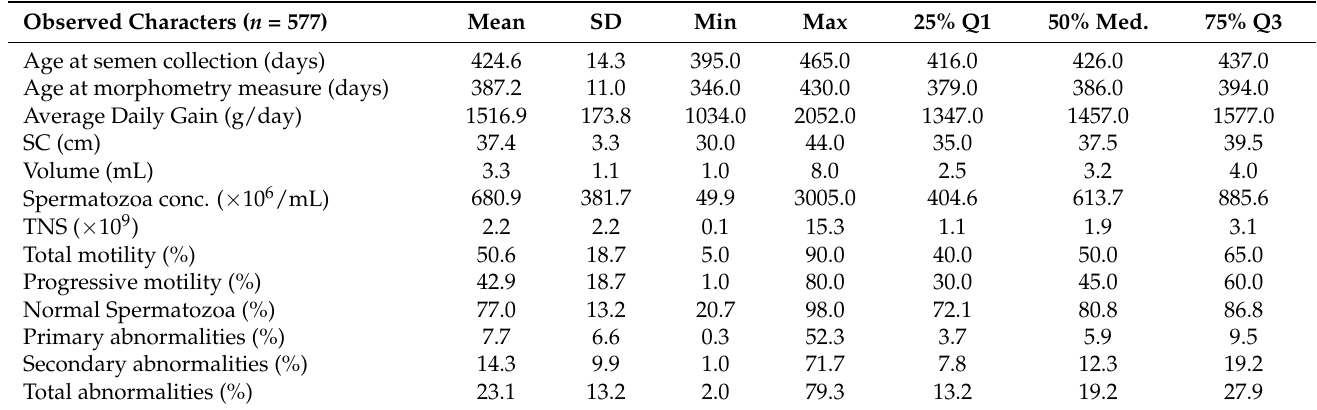
Table 2. Descriptive statistics about physiological and seminal characteristics of Italian Simmental young bulls.